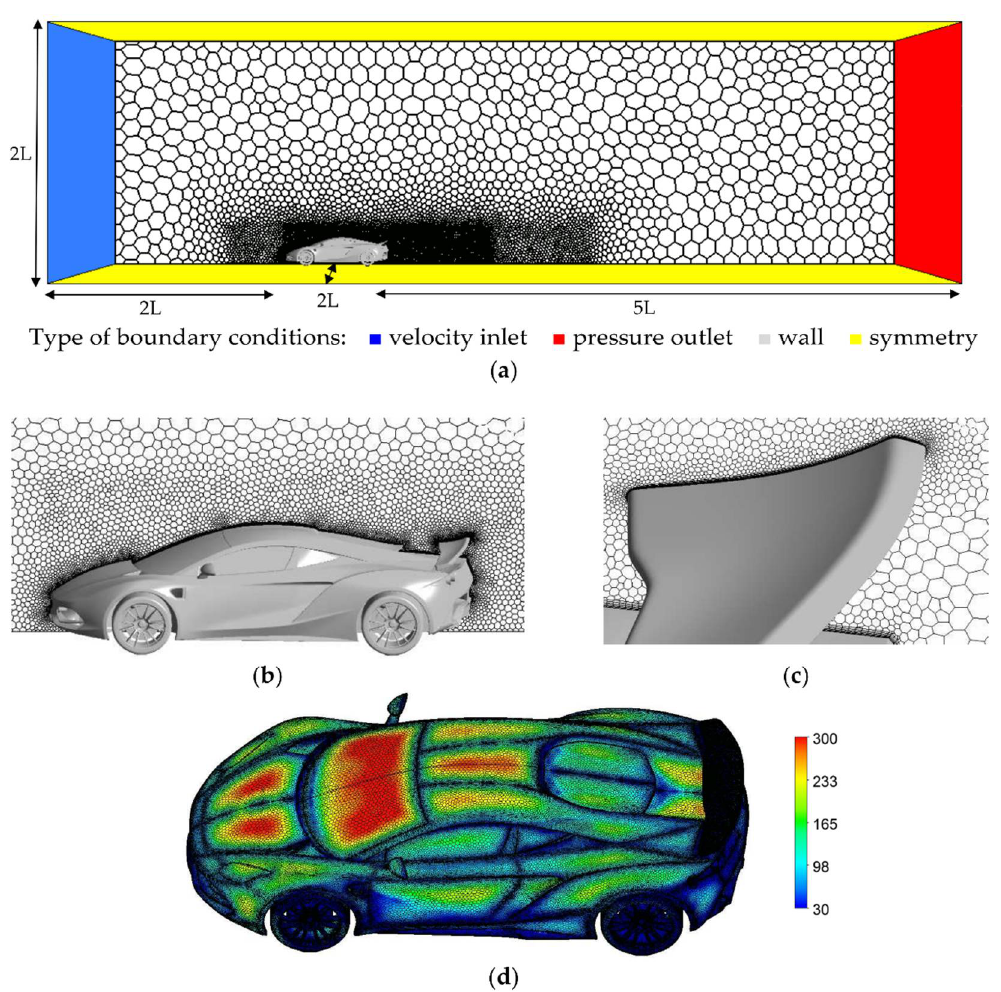
Figure 1. ( a ) Computational domain with mesh at the symmetry plane (letter L is the length of the car); ( b ) close-up on the mesh around the car; ( c ) the rear wing; ( d ) y+ values on the car body with superimposed surface mesh edges.